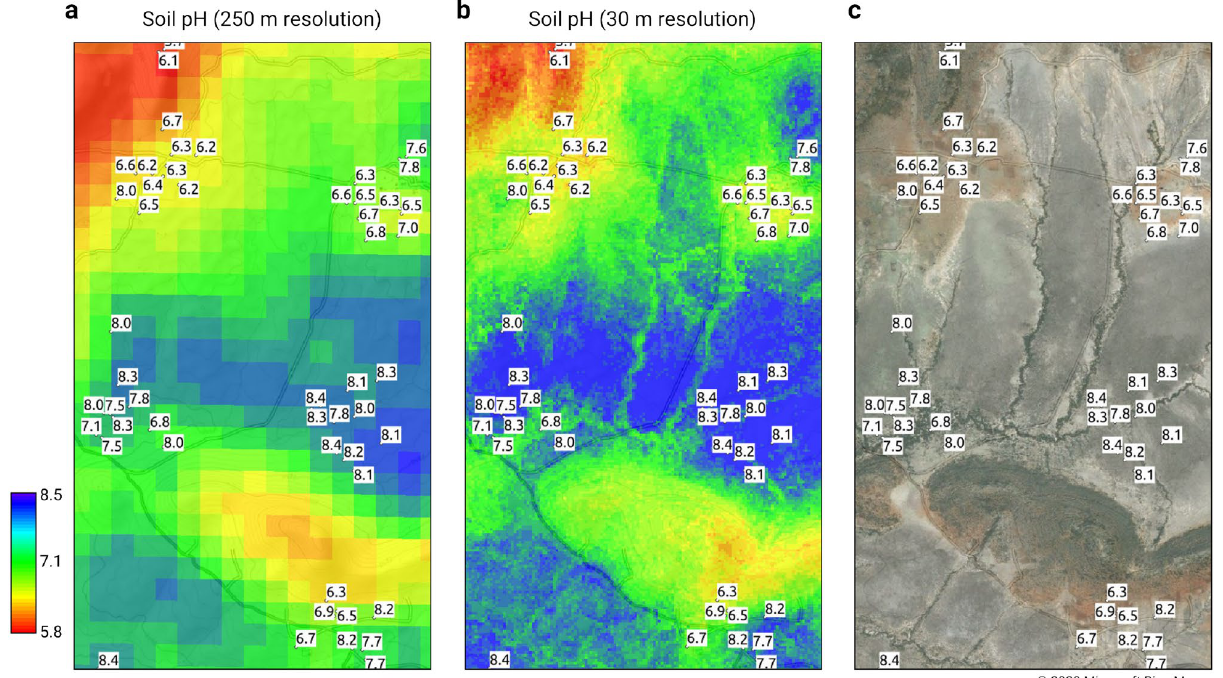
Figure 5. Illustration of differences in spatial detail of predictions for soil pH for top-soil: ( a ) previous predictions at 250 m published in Hengl et al. 17 , ( b ) current predictions at 30 m, which seem to match very well physical patterns seen on the satellite imagery ( c ). Sentinel site area in southern Kenya. Visualizations produced using QGIS v3.10 (https ://www.qgis.org/). Satellite image in c copyright 2020 Microsoft Bing